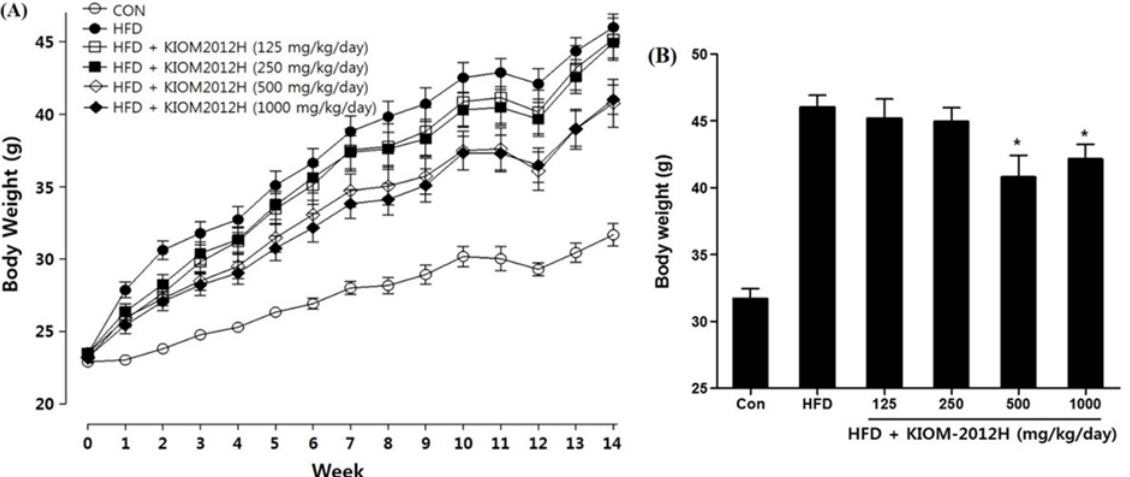
Figure 5. The changes in body weight during all the experimental period ( A ) and at necropsy ( B ) were dose-dependently decreased in HFD-fed mice ( n = 13) as well as with KIOM2012H. Statistical differences from HFD are indicated by asterisks ( * p < 0.05, ** p <